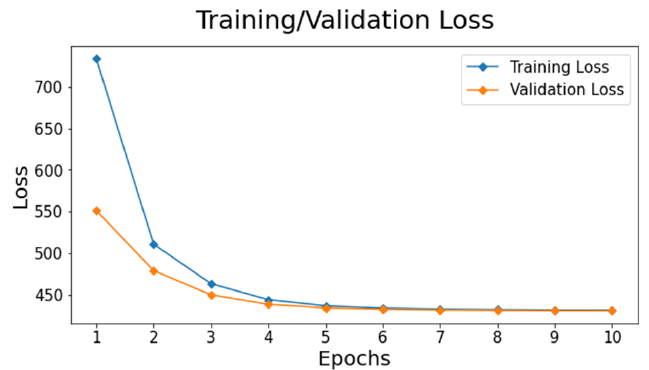
Figure A3. Training and validation loss vs. epochs.